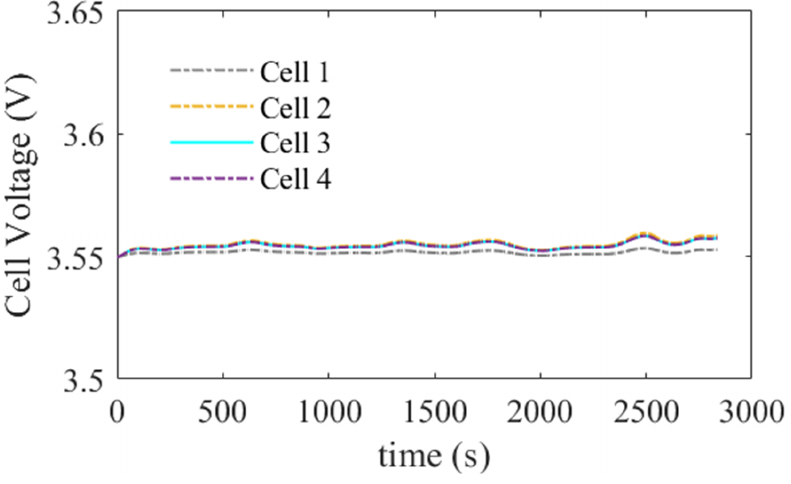
Figure 13. Experimental results of the battery block cell voltage